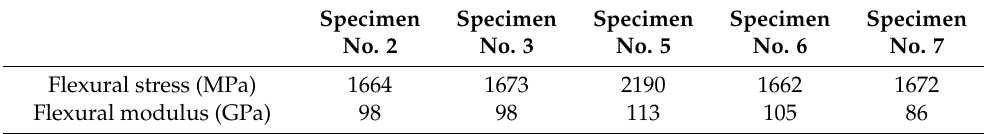
Table 10 . Calculated mechanical properties for different specimens.